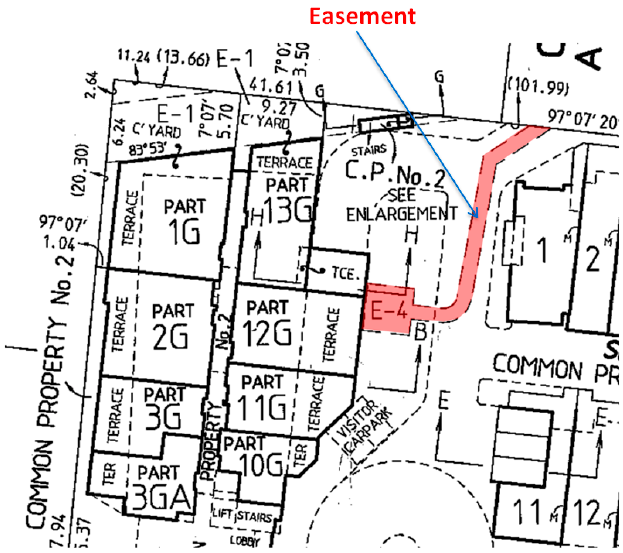
Figure 6. An easement depicted in a plan of subdivision, adapted from [29] (p. 509).